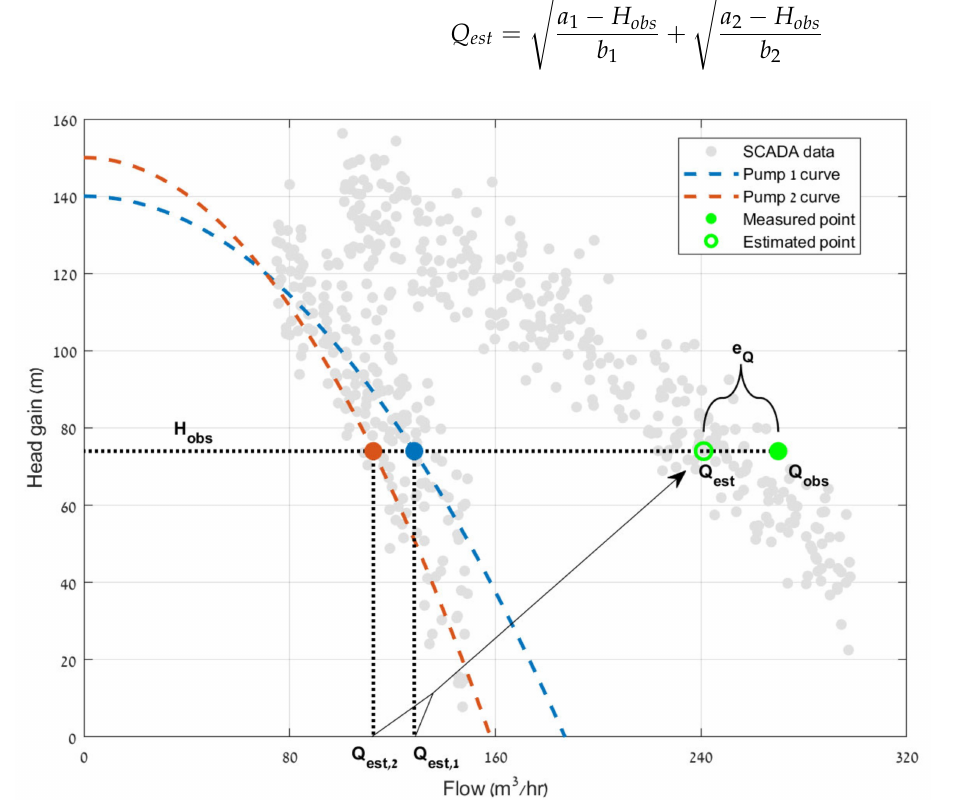
Figure 3. The horizontal error for two fixed speed